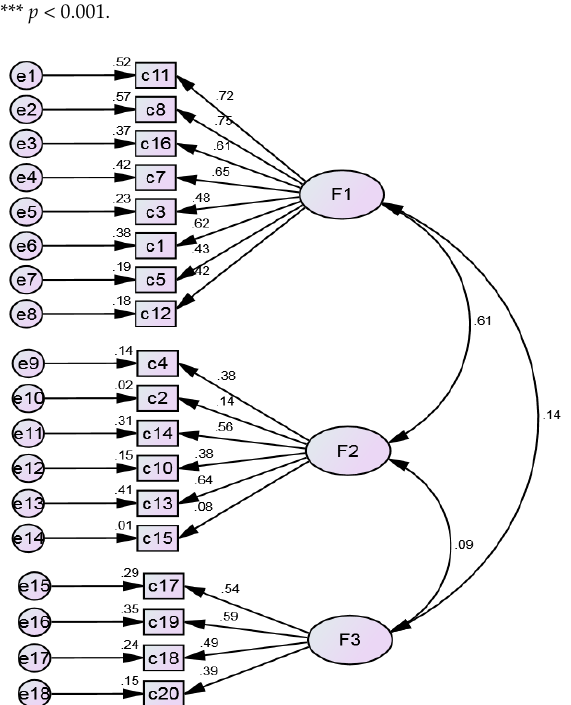
Figure 2. Early Figure 2. Early model.